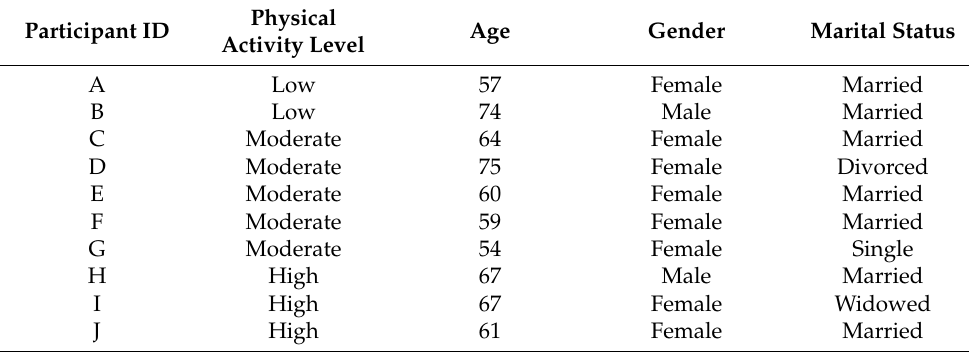
Table 2. Participants’ demographic